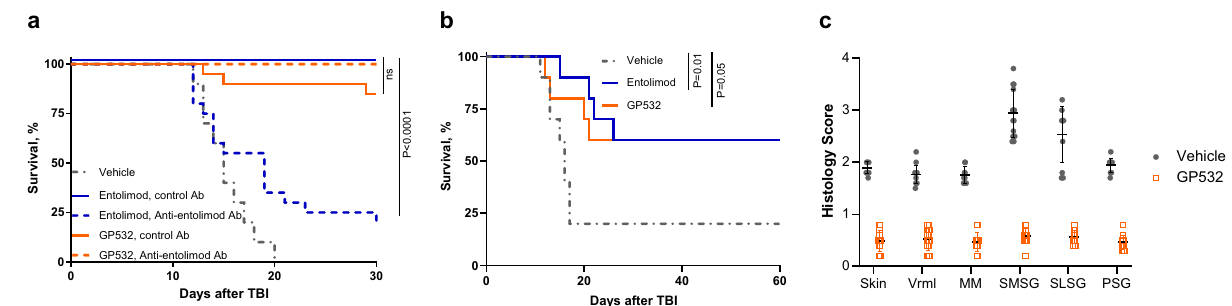
Fig. 10 Therapeutic ef fi cacy of entolimod and GP532 in mice exposed to lethal total body irradiation (TBI) or sublethal local H&N irradiation. a Radioprotective potency of GP532 and entolimod administered to NIH Swiss mice (s.c., 1 μ g/mouse) 30 min before lethal TBI (8.5 Gy) in the presence of “ anti-entolimod Ab ” (serum from entolimod clinical trial patients with high levels of entolimod-reactive neutralizing Abs) or “ control Ab ” (normal human serum with a very low level of entolimod-reactive Abs). n = 10 for vehicle-treated group, n = 20 for all other groups. b Radiomitigative activity of GP532 and entolimod administered to BALB/c mice (s.c., 1 μ g/mouse, n = 10 per group) 24 h after lethal TBI (7.5 Gy). For a , b , P values by Log-rank test are shown; ns, not signi fi cant. c Tissue-protective activity of GP532 in female FVB/NJ mice ( n = 15 per group) injected s.c. with 0.3 μ g GP532 (or PBST as a negative control) 30 min before 15 Gy irradiation (X-ray) to the H&N region. H&E-stained sections of lips (skin, vermilion (Vrml), and mouth mucosa (MM)) and salivary glands (submandibular salivary glands (SMSG), sublingual salivary glands (SLSG), and parotid salivary glands (PSG)) collected 30 days post-irradiation were scored for injury on a scale of 0 (normal morphology) to 4 (most severe damage). Markers show individual sample scores ( n = 12 – 15 independent samples (mice) per group); horizontal bars show the per group mean scores with error bars indicating SD. For all tissues, the difference in mean histology scores between PBST and GP532 groups was statistically signi fi cant ( P < 0.0001 by two-tailed unpaired t